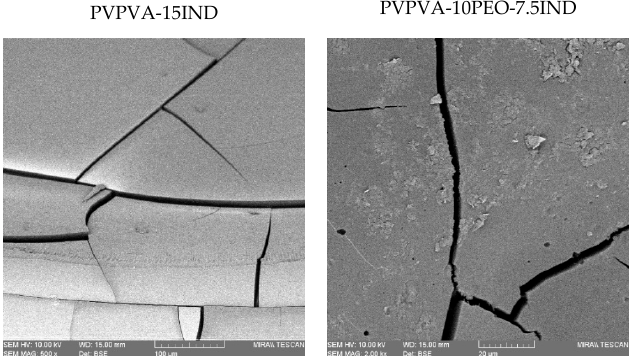
Table 3. Uniformity of weight and IND content of tablets fabricated using